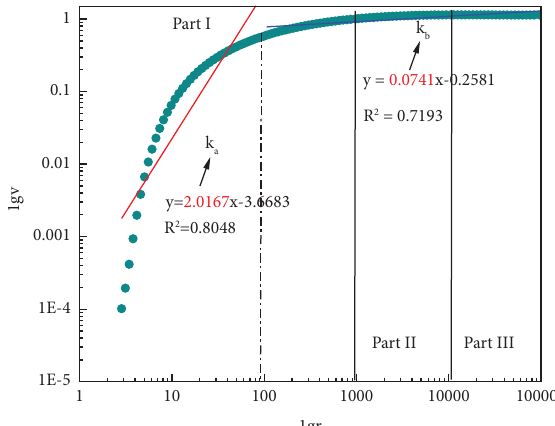
Figure 6: Te lgV and lgR relation curves of the NMR fractal dimension model.